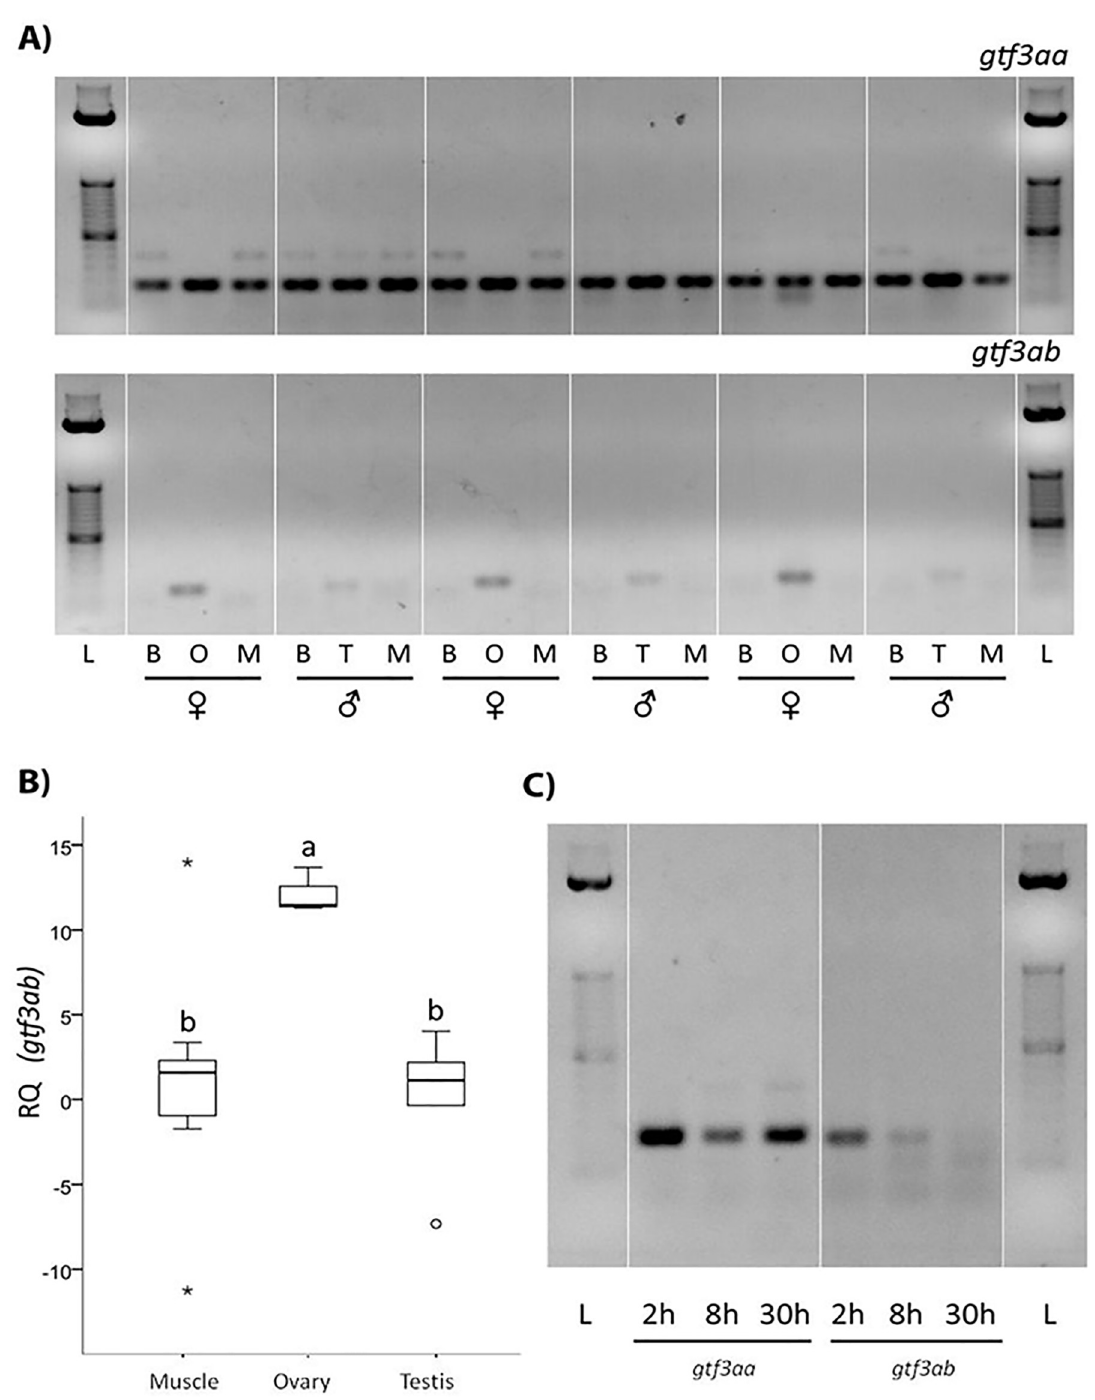
Fig 3. Transcription levels of gtf3aa and gtf3ab in different tissues and developmental stages of zebrafish. A) Agarose gel electrophoresis showing presence vs absence of gtf3aa and gtf3ab transcript levels after End-Point RT-PCR in organs of three male and three female individuals. Brain (B), ovary (O), testis (T) and muscle (M). Amplified fragments of 100 ( gtf3aa ) and 114 ( gtf3ab ) nucleotides were observed in each case. L = Standard 50 bp (Invitrogen). B) Transcription levels of gtf3ab in different tissues of adult zebrafish through qPCR. Box plots represent the data within the 25th and 75th percentiles, with the median indicated by a line, and top and bottom whiskers indicating the minimum and maximum values. Different letters indicate significant differences between means (Mann Whitney, p < 0.05). Number of samples, 6 for ovary, 3 for muscle and 4 for testes. C) Agarose gel electrophoresis afterEnd-Point RT-PCR amplification showing transcription levels of gtf3aa and gtf3ab in zebrafish embryos 2, 8 and 30 hpf. Amplified fragments were around 100 nucleotides in size. L = Standard 50 bp